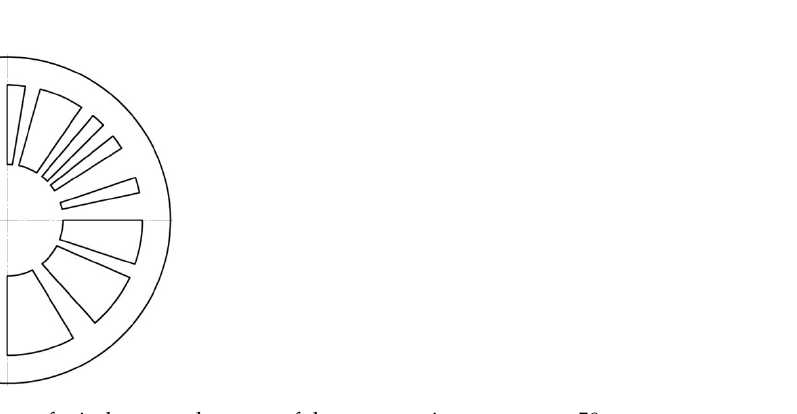
12 of 22 Figure 6. Placement of windows on the stator of the pneumatic system of the rotor type. We divide the rotor disk circular curve into 59 equal parts (number of places m = 59). In the open interval of numbers 0…59 we calculate the perfect squares: 0, 1, 4, 9 and so on.